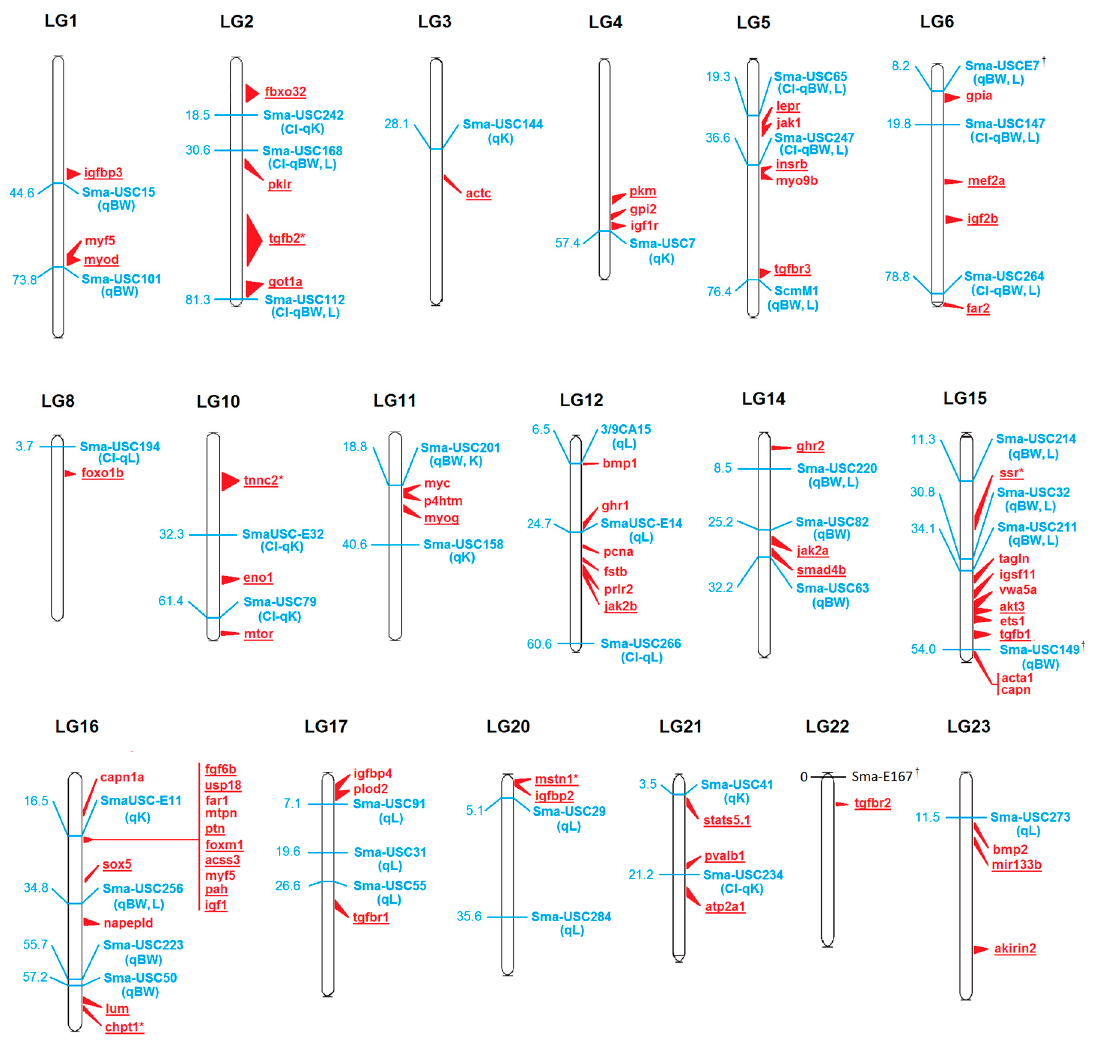
Figure 2. Predictive genome position of growth-related genes in the turbot genetic map. Estimated gene map positions are shown in red, underlining the 45 selected genes for SNP detection. (*) Map positions inferred by comparative mapping against model fish [26]. Reported growth-related markers [29,30,32] are shown in blue, either associated with growth traits (qBW, body weight; qL, length; qK, Fulton factor) or located within the confidence interval (CI) of growth QTLs. (†) Outlier markers proposed to be under selection in turbot [32].